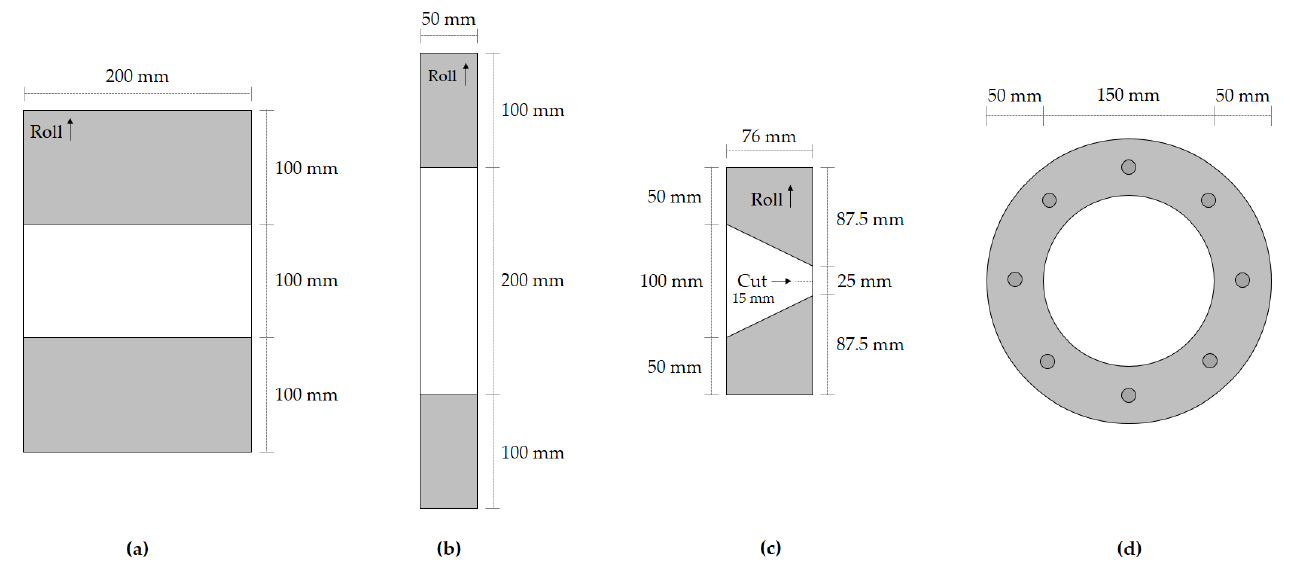
Figure 1. Schematic representation of the specimens used in: ( a ) tensile tests according to EN ISO 10319 [31]; ( b ) tensile tests according to EN 29073-3 [28]; ( c ) tearing tests; ( d ) static puncture tests. The roll arrows indicate the machine direction of production. The gripping area is indicated in grey.